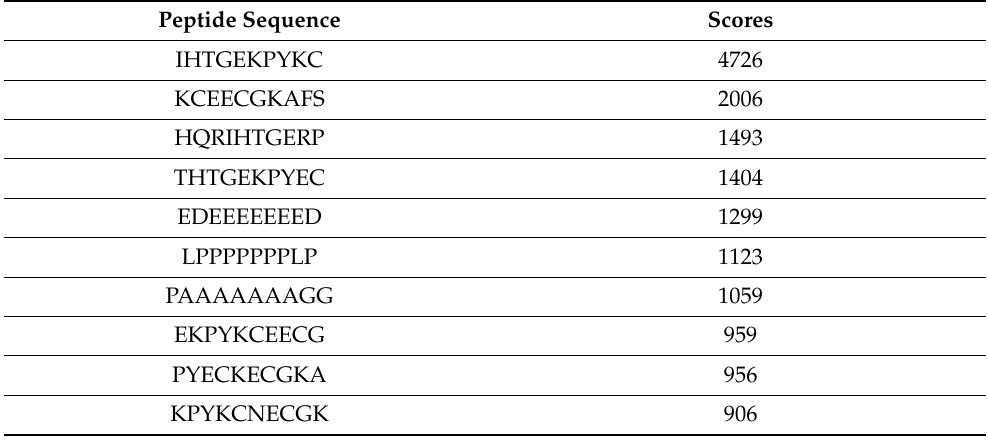
Table 1. Ten highly-scored peptides.